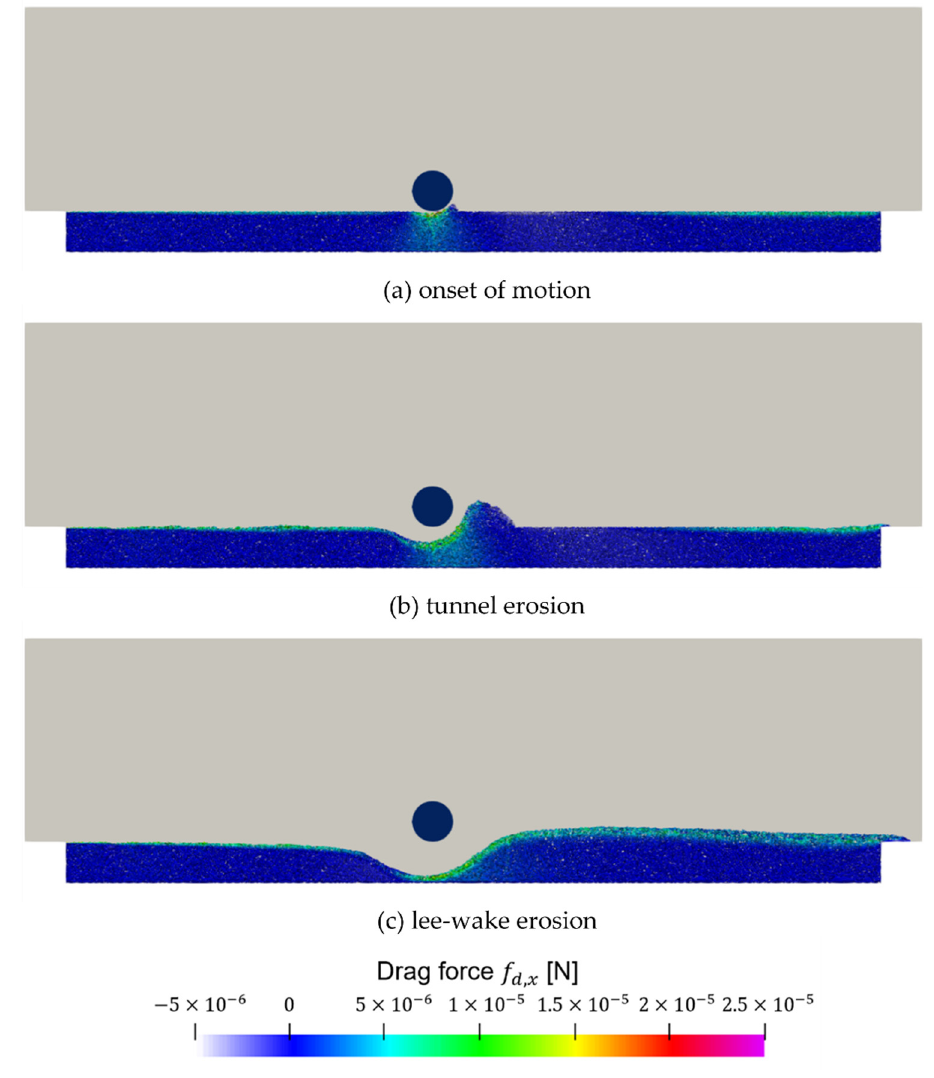
Figure 14. The x-directional particle drag force ( f d , x